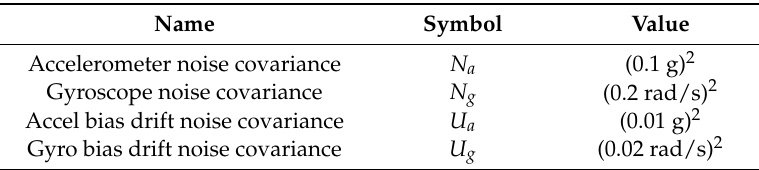
Table 2. Parameter list of IMU noise.